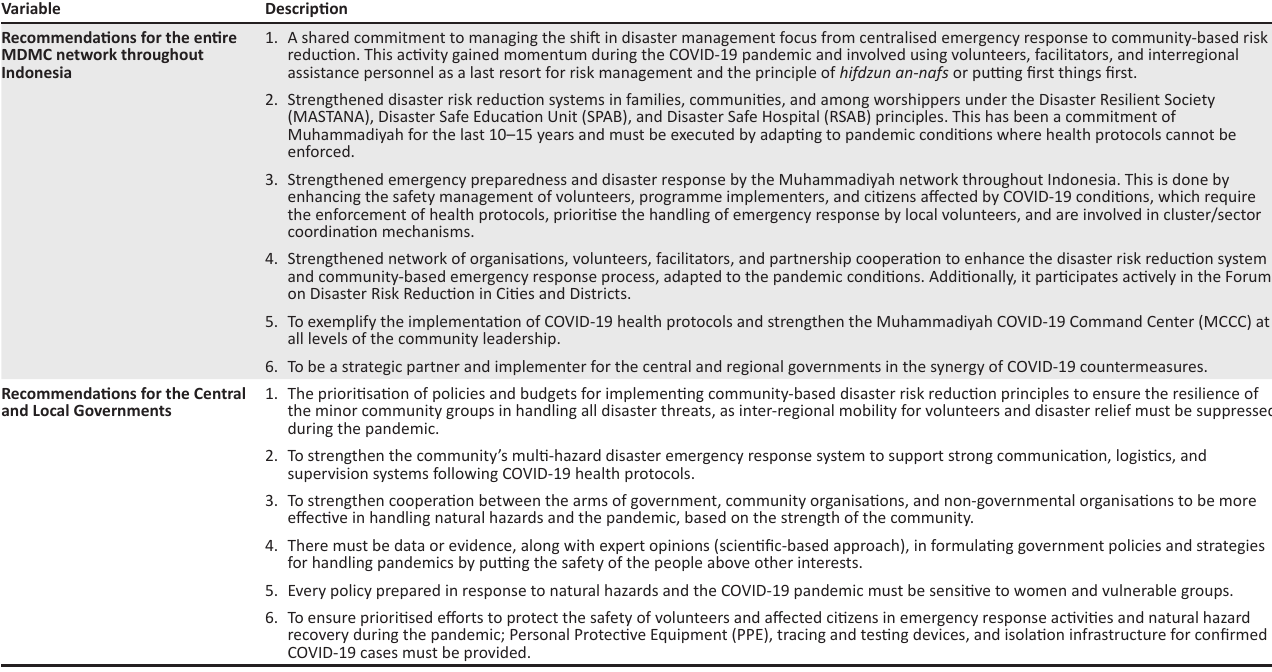
TABLE 1: Muhammadiyah Disaster Management Center (MDMC) Recommendations on Handling Natural Hazards During the Pandemic.